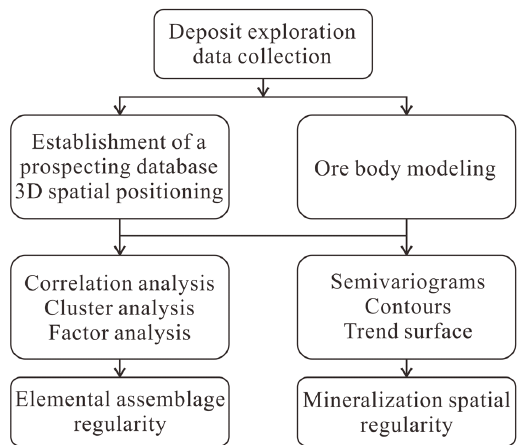
Figure 4. The methodological flowchart implemented in this study.